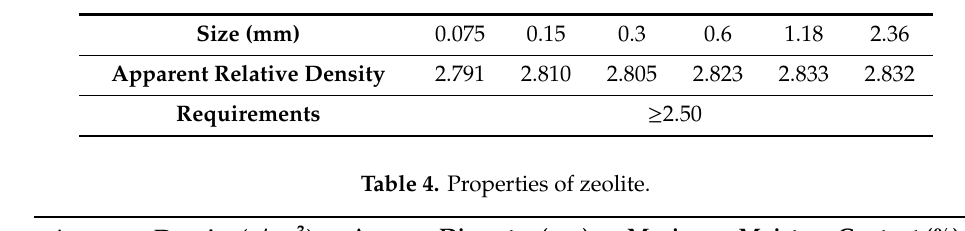
Table 3. Apparent density of fine aggregates.